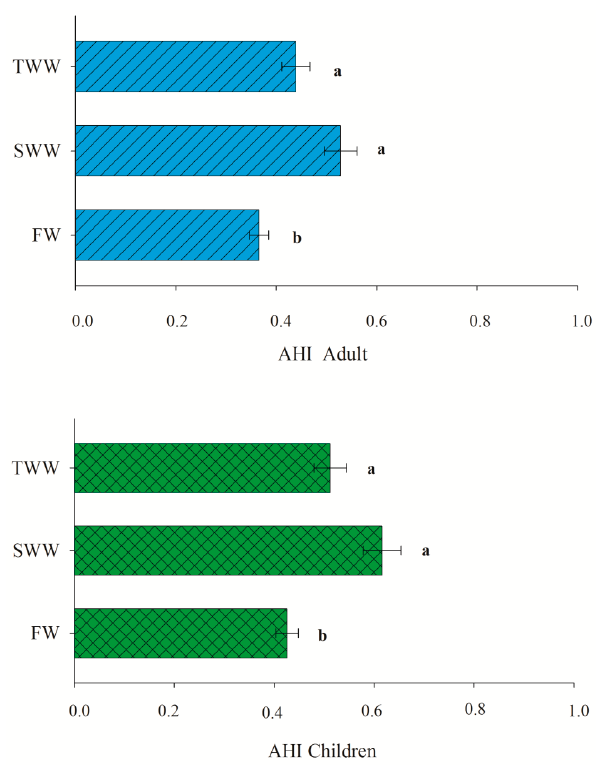
Figure 4. Additive hazard risk index (AHI) for adults and children for the combined heavy metals detected in artichoke heads. FW, fresh water; SWW, secondary treated wastewater; TWW, tertiary treated wastewater. Different letters (a–b) indicate statistically significant differences ( p ≤ 0.05; Tukey’s test). The data shown are the means ± standard errors of 6 samples (3 replicates × 2 growing